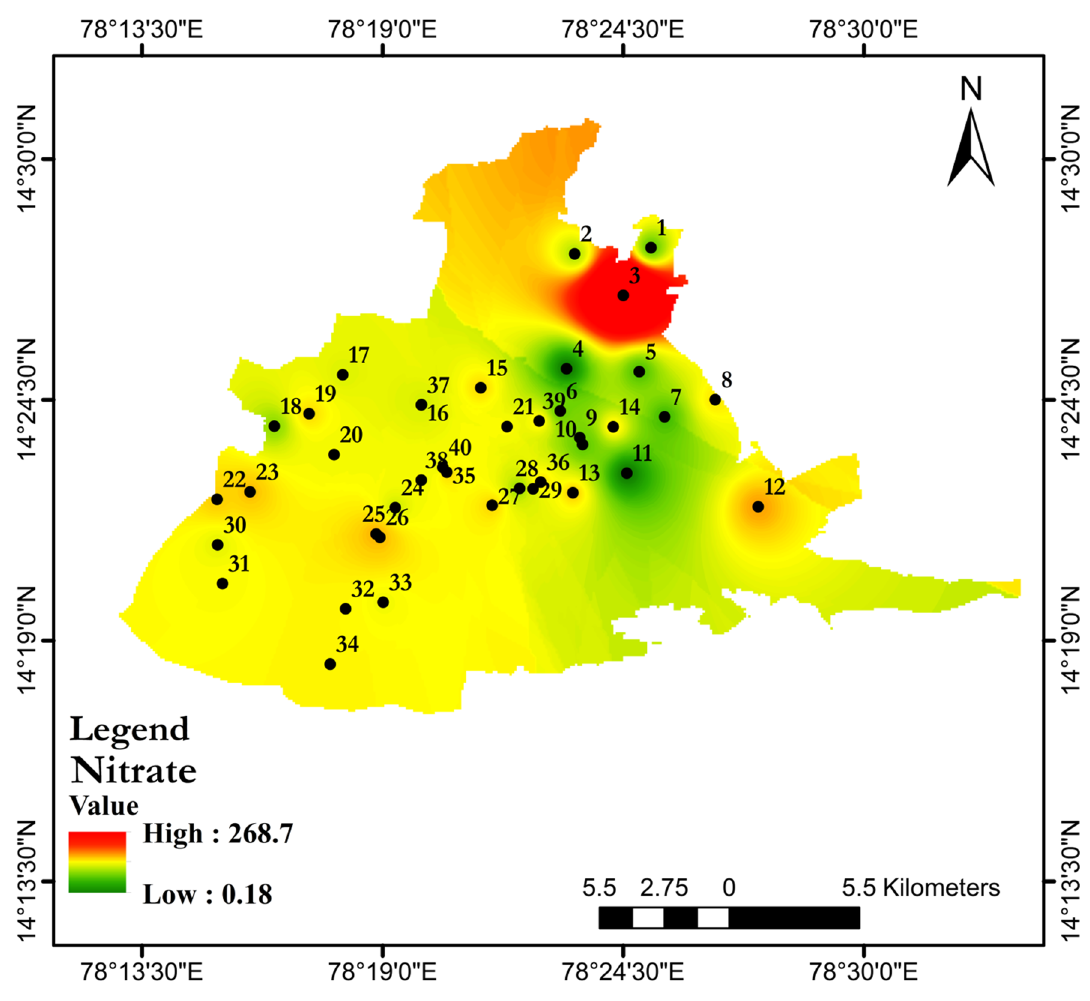
Fig. 3 Spatial distribution map of nitrate contamination